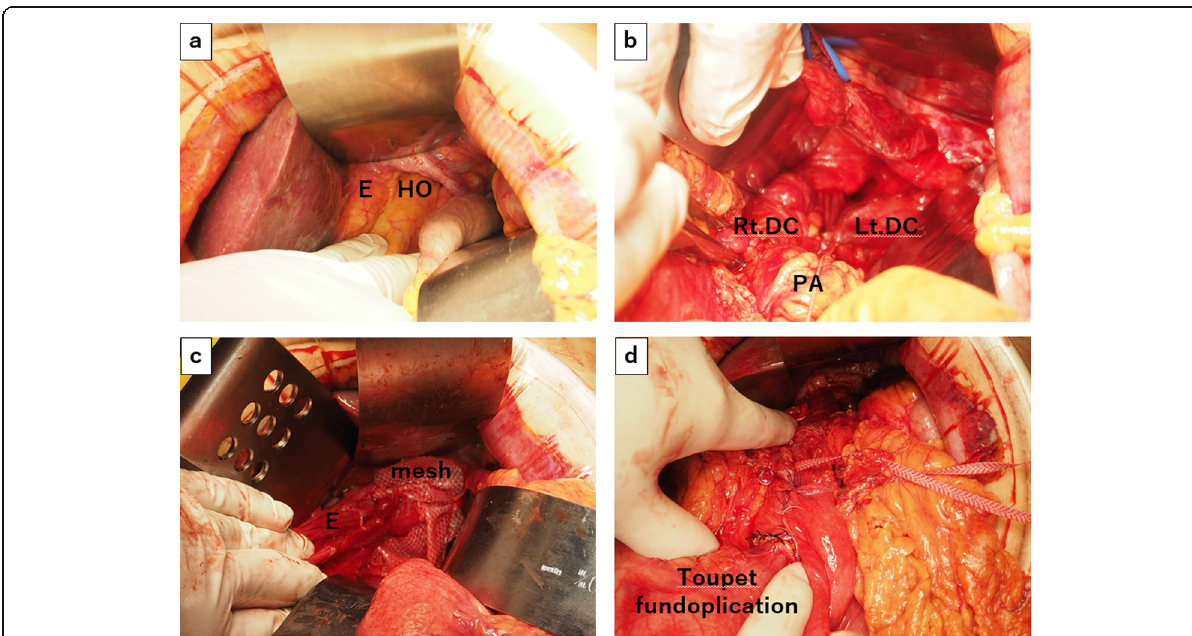
Fig. 6 Surgical procedure. a Surgical view through the incision. The stomach, omentum, and the contents of the hernia were mobilized into the abdominal cavity manually. E: esophagus, HO: hernial orifice. b There was a strong adhesion between the tail of the pancreas and the right diaphragmatic crus, and the right pleura was damaged unexpectedly, which required closure and placement of a tracheal tube. DC: diaphragmatic crus, PA: pancreas. c The hiatal orifice was closed by silk thread sutures (primary repair), and mesh was fixed in front of the hernial orifice; E: